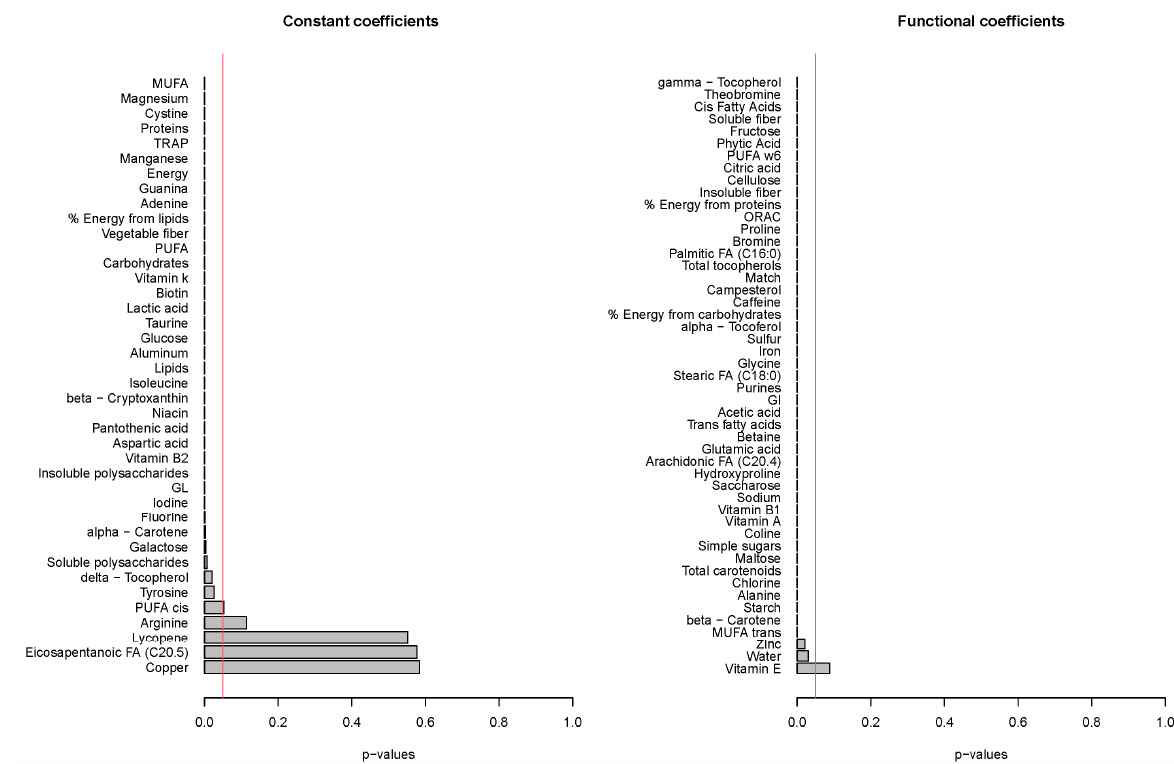
Figure 4. The significance of the constant and functional model coefficients.